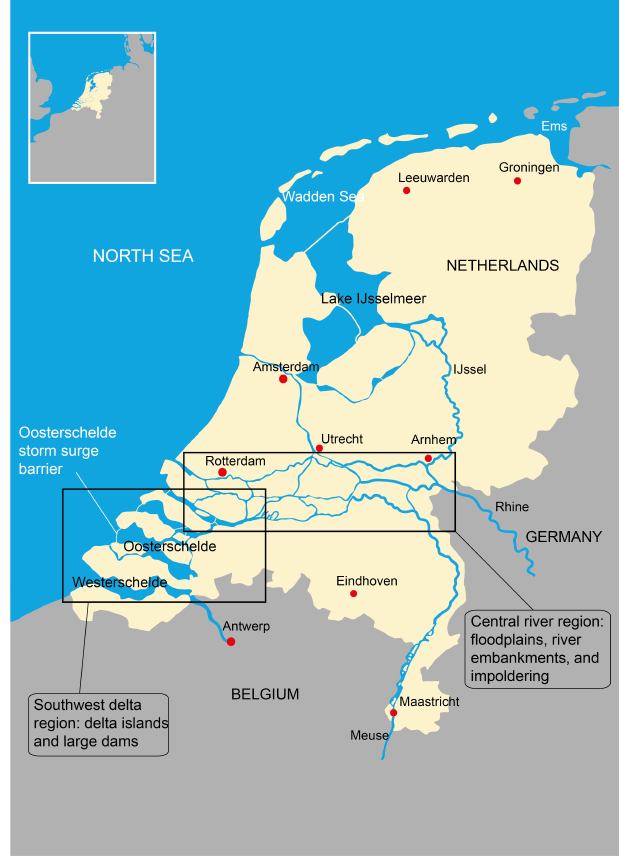
Fig. 1 . The Netherlands, located in Northwest Europe. Source: Martijn van Staveren. For additional images and background on the Oosterschelde storm surge barrier and Dutch river embankments, see http://www.martijnvanstaveren.blogspot. nl/2016/01/background-info-oosterschelde-storm.html and http://www.martijnvanstaveren.blogspot.nl/2016/01/ background-info-embankments-in.html,